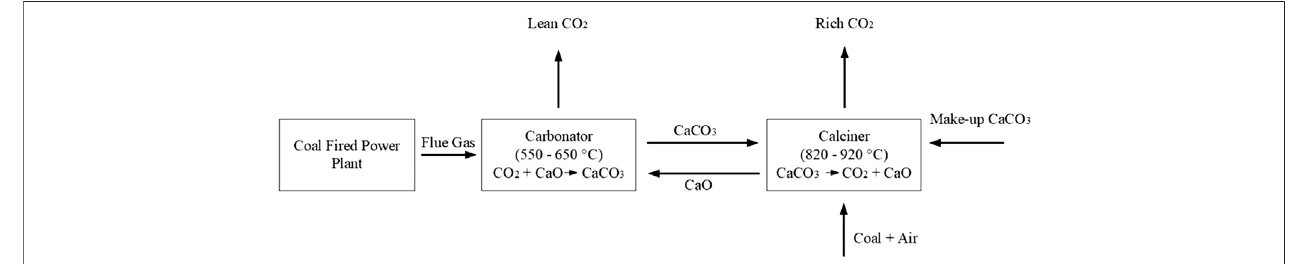
FIGURE 2 | PFD of integrated coal fi red power plant and CCL